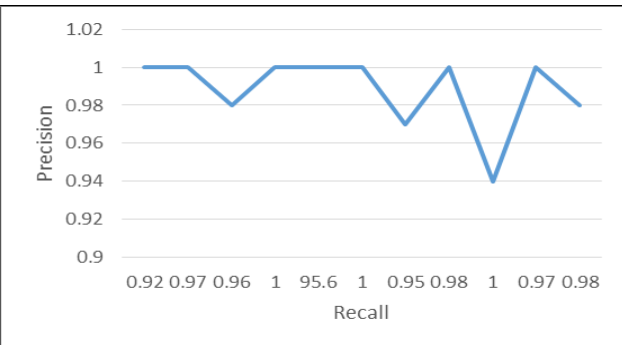
Figure 11. ROC Curve for PoC Class- 1